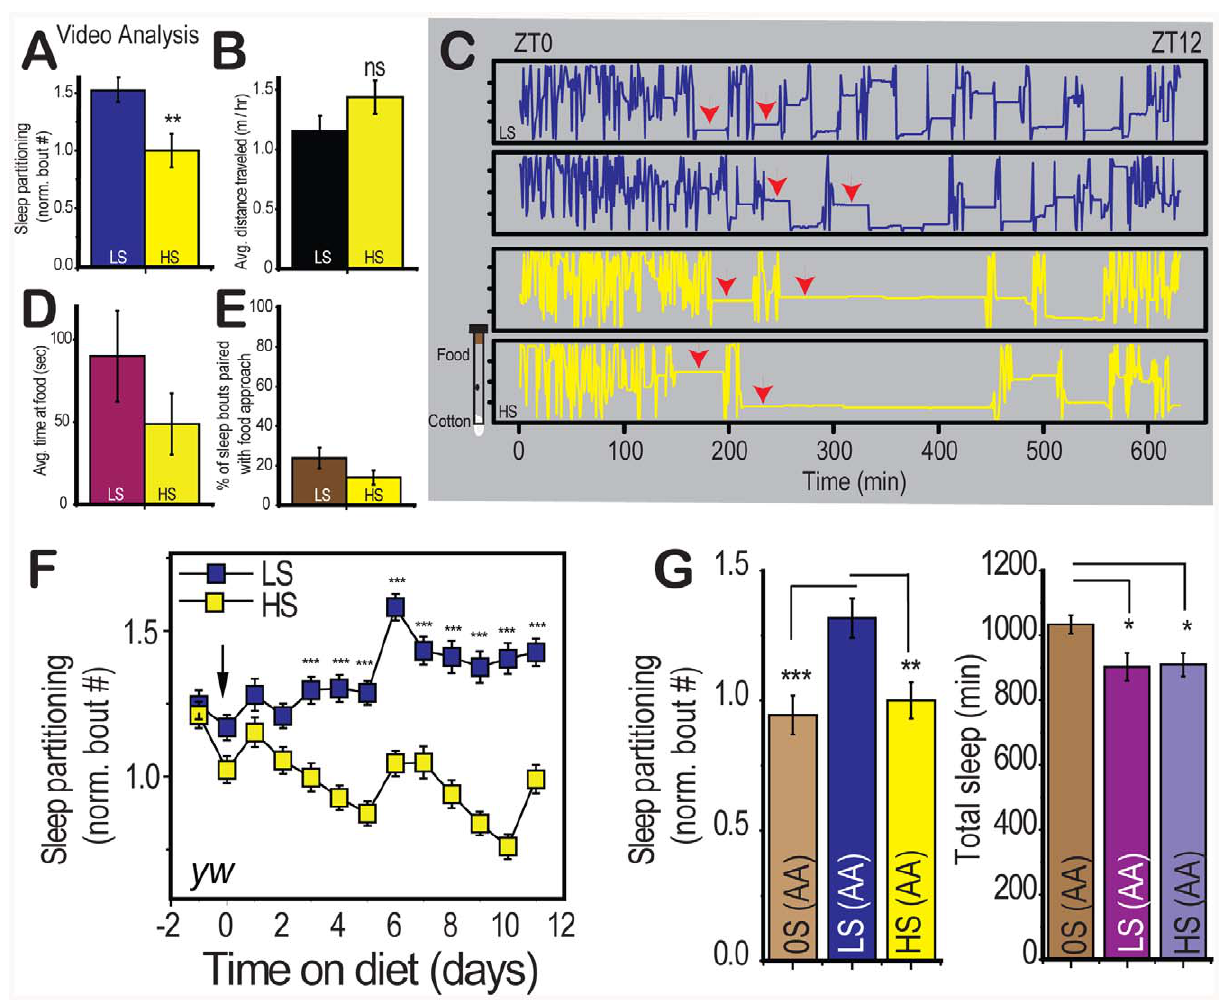
Figure 2. Characterization of diet-induced changes to sleep architecture. (A) Video tracking analysis confirms the effect of sugar on sleep bout number was significant when the position of individual control ( yw ) flies was tracked with video monitoring (n=15 per group). (B) The average distance traveled per hour was not significantly different between dietary conditions. (C) Position traces along the length of the food vial are plotted across time for two individuals per dietary condition.Arrows indicate the presence of sleep episodes. The food is oriented at the top and the cotton plug is at the bottom in this visualization (see graphic to the left of the plots) (D) The average time spent in a trip to the food and (E) the percent of sleep bouts resulting in an approach to the food within two minutes were not significantly different between dietary conditions. (F) Control flies were switched from 10% sucrose:yeast fly medium to LS (2.5% sucrose) or HS (30% sucrose) in a 2.5% yeast base medium on day zero and sleep was measured for the subsequent 12 days. Flies were switched to fresh food on day 6. Each point represents the avergage + / 2 SEM for a 24 hour period.(G) Control flies were placed on a yeast-free amino acid mixture containing either 0%-OS(AA), 2.5%-LS(AA), or 30%-HS(AA) sucrose in order to compare complete sugar deprivation to the low and high sugar condition on a consistent sugar-free base medium. Error bars represent mean + / 2 SEM for each group. *** p , 0.001, ** p , 0.01,* p , 0.05 for all statistical calculations. Significance values for t-tests between dietary conditions are shown above each set of bars. For panel C, significance values were calculated by one-way ANOVA followed by Fisher LSD for comparison between groups. See Figure S2 for additional supporting evidence.